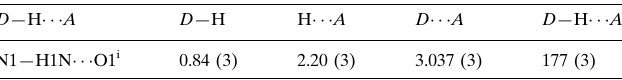
Hydrogen-bond geometry (A˚ , (cid:4)